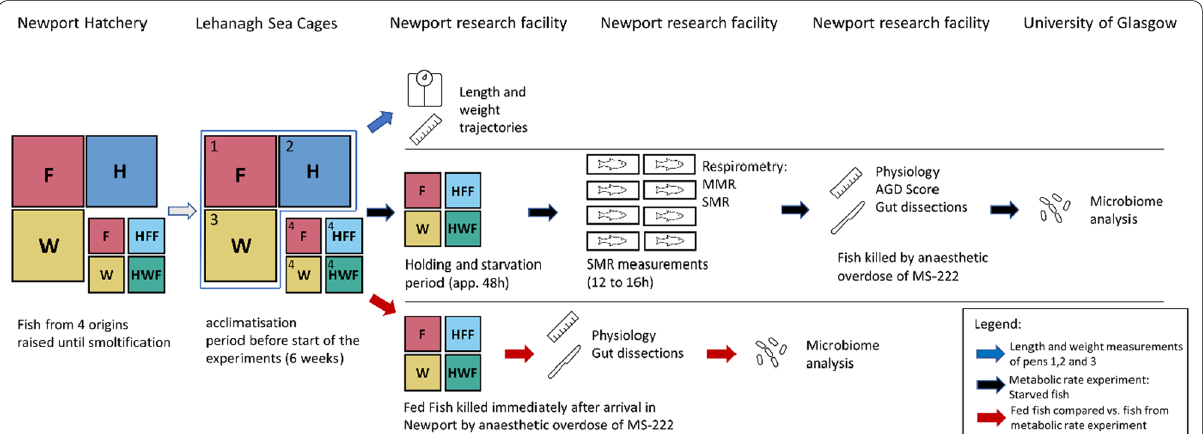
Fig. 1 Flow chart of the experimental setup. Fish from four genetic backgrounds were used: Farmed (F), wild (W) and their reciprocal hybrids named after the origin of the mother (hybrid farmed female (HFF) and hybrid wild female (HWF)). Fish from pens 1–3 were used for length and weight trajectories (blue arrow). PIT tagged fish from pen 4 were used for the respirometry experiment and microbiome analysis (black arrow). In addition, we compared starved fish from the metabolic rate experiment with recently fed fish at two different sampling timepoints T0 (day 0 of respirometry experiment) and T1 (day 14 of the respirometry experiment) (red